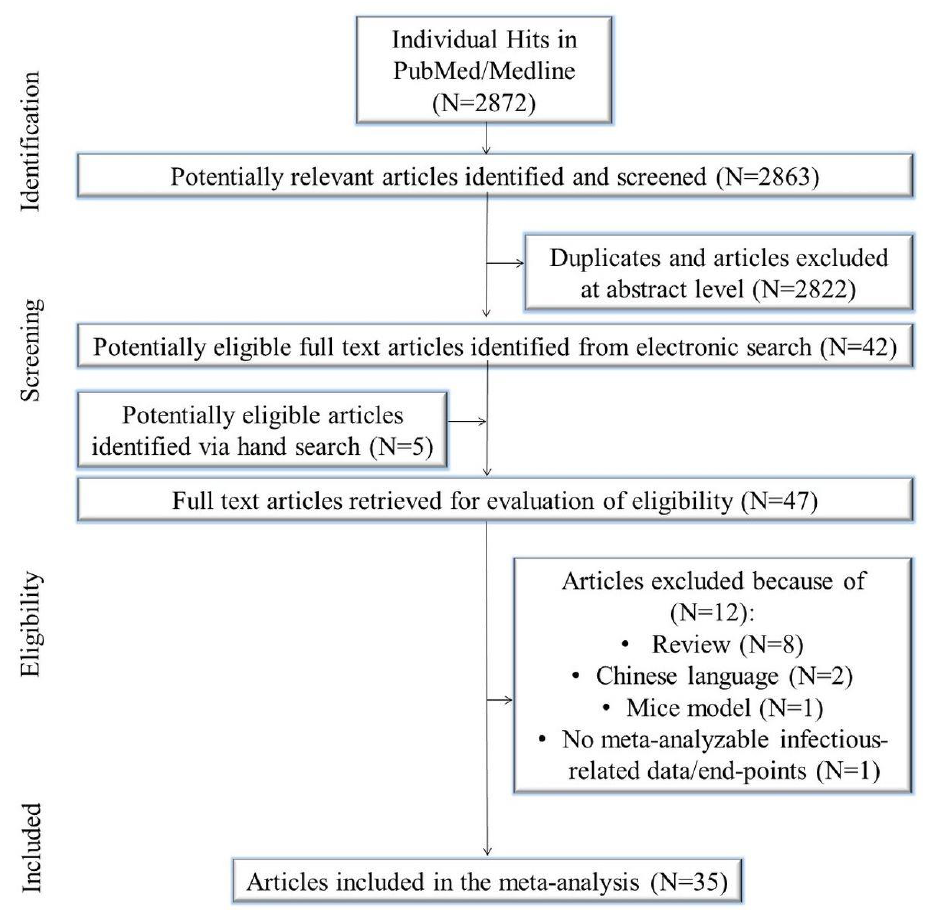
Figure 1. Study flow chart.